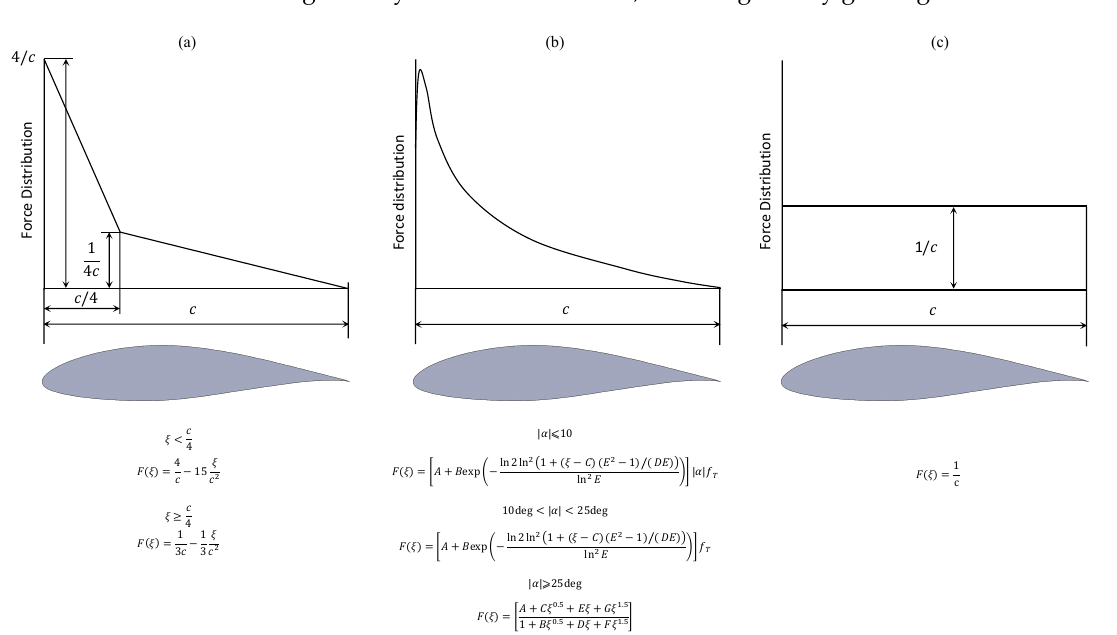
Figure 3. Examples of chordwise distribution of the blade load in the AS model for ( a ) piece-wise linear distribution [36], ( b ) data-fitted distribution [9], and ( c ) constant distribution